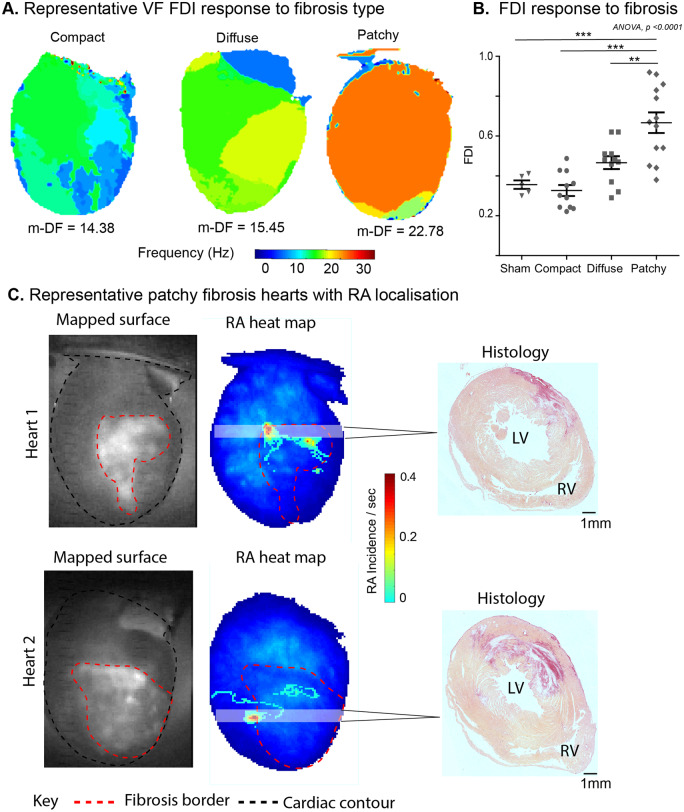
PF anchors RAs and sustains the most globally organized fibrillation. (A) Representative DF maps in differing fibrosis groups; CF, DiF, and PF hearts in VF. The DF of the largest organized region or the m-DF is indicated below in hertz (Hz). (B) A graph showing the highest FDI in the PF group in comparison to DiF and CF. (C) Two representative PF hearts showing the mapped surface with fibrosis border in view (left), phase processed RA heat maps (middle), and corresponding histological cross-section from the shaded region (pink, pale yellow = normal myocardium, dark red = fibrosis, scale—black bar = 1 mm). Data from sham surgery (n = 5), CF (n = 11), DiF (n = 11), and PF (n = 13) hearts. Statistical analysis with ANOVA, post hoc Bonferroni multiple comparisons test, **P < 0.01, ***P < 0.001. m-DF, maximal DF.